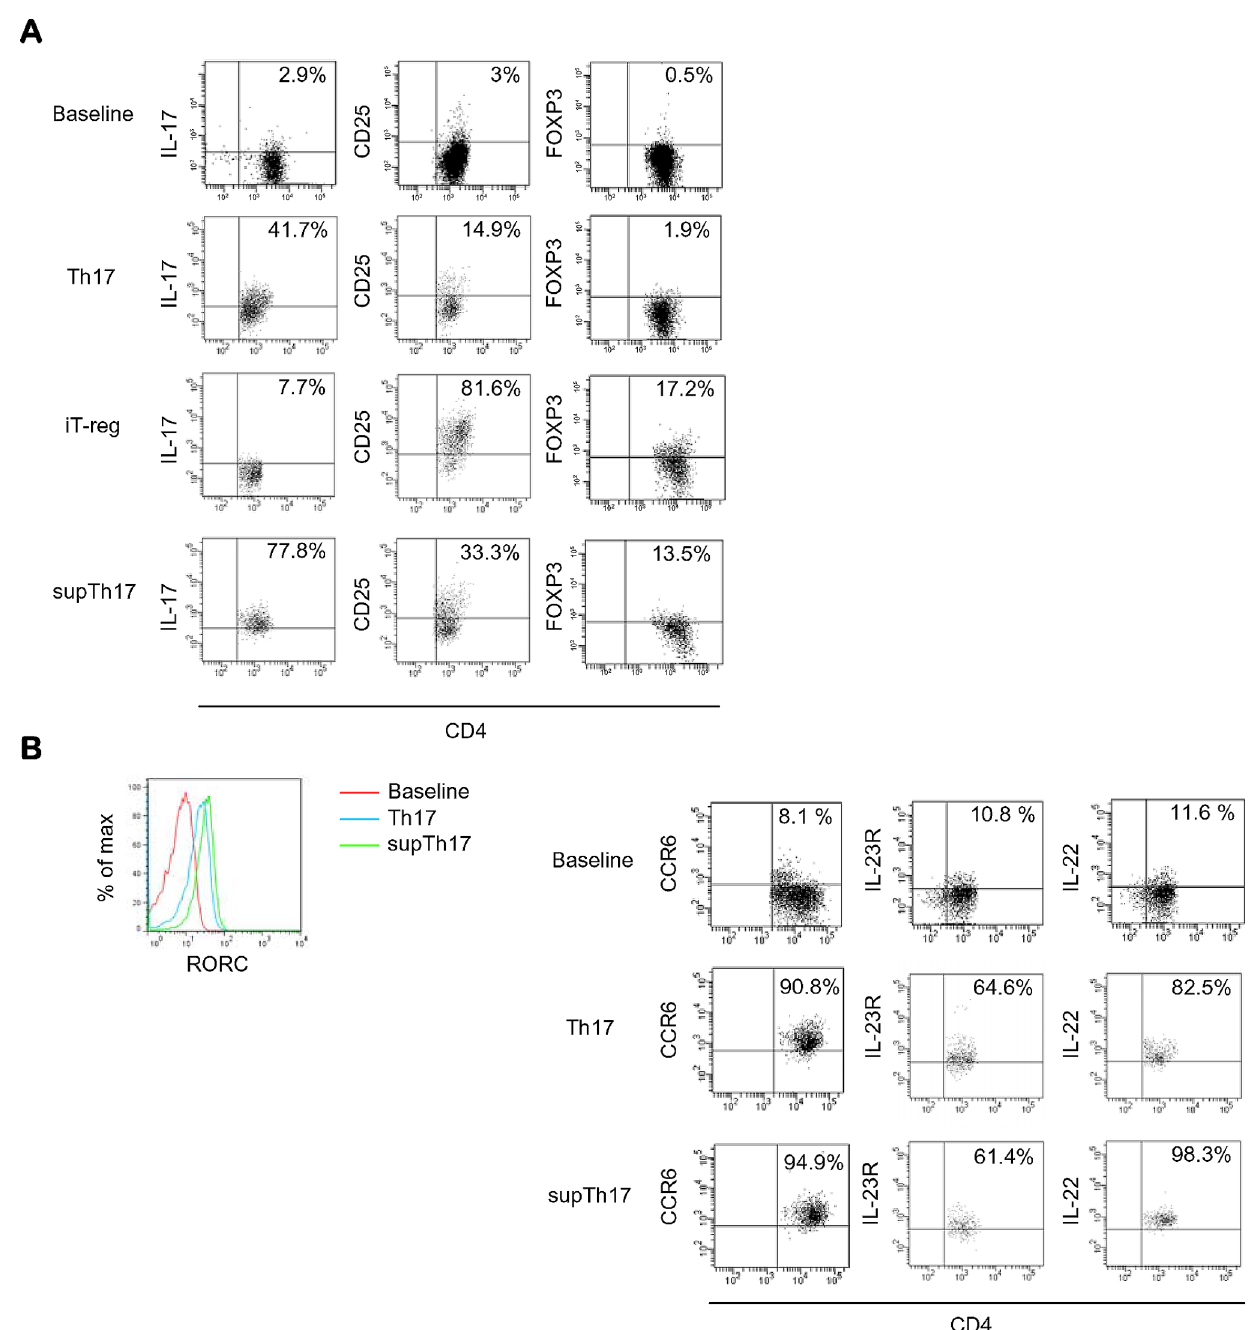
Figure 2. Phenotypic properties of supTh17. Phenotype of CD4 mem at baseline and of Th17, obtained from CD4 mem after 3-day exposure to IL- 6 + IL-1 b + rTGF- b ; iT-reg, obtained following exposure of Th17 to high concentration IL-2 and T-cell expander; and supTh17, obtained upon iT-reg exposure to IL-6 + IL-1 b + rTGF- b . Cell phenotype was determined in 12 healthy subjects. (A) Representative flow cytometry plots of CD4 ( X axis) and IL- 17, CD25 and FOXP3 ( Y axis) fluorescence. (B) Representative histogram depicting RORC fluorescence in CD4 mem at baseline, Th17 and supTh17; representative flow cytometry plots of CD4 ( X axis) and CCR6, IL-23R and IL-22 ( Y axis) fluorescence. Compared to prototypic Th17, supTh17 display higher frequencies of IL-17 + , FOXP3 + and IL-22 + lymphocytes, express similar levels of RORC and contain comparable numbers of CCR6 + cells. doi:10.1371/journal.pone.0087956.g002 4 days in the presence of iT-reg polarizing conditions consisting of conditions are referred to as Th17 and iT-reg; cells obtained after high concentration IL-2 (300 U/ml) and T-cell expander (bead/ iT-reg exposure to Th17 driving conditions are indicated as cell ratio: 1/2) [39,40] and then re-exposed to the same Th17 supTh17 (Figure S1). Functional properties of Th17, iT-reg and polarizing conditions indicated above for additional 3 days (Figure supTh17 are described in the ‘Results’ section. S1). Cells obtained after exposure to Th17 and iT-reg polarizing